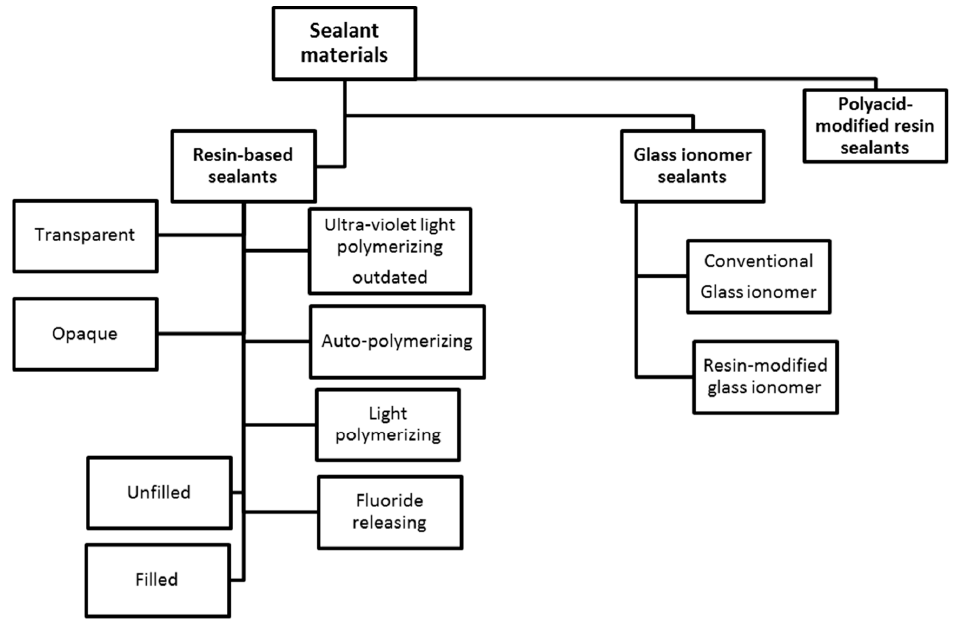
Figure 1. Classification of sealant materials.